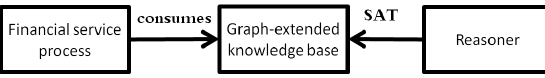
Figure 2. Encoding FSP to graph-extended knowledge